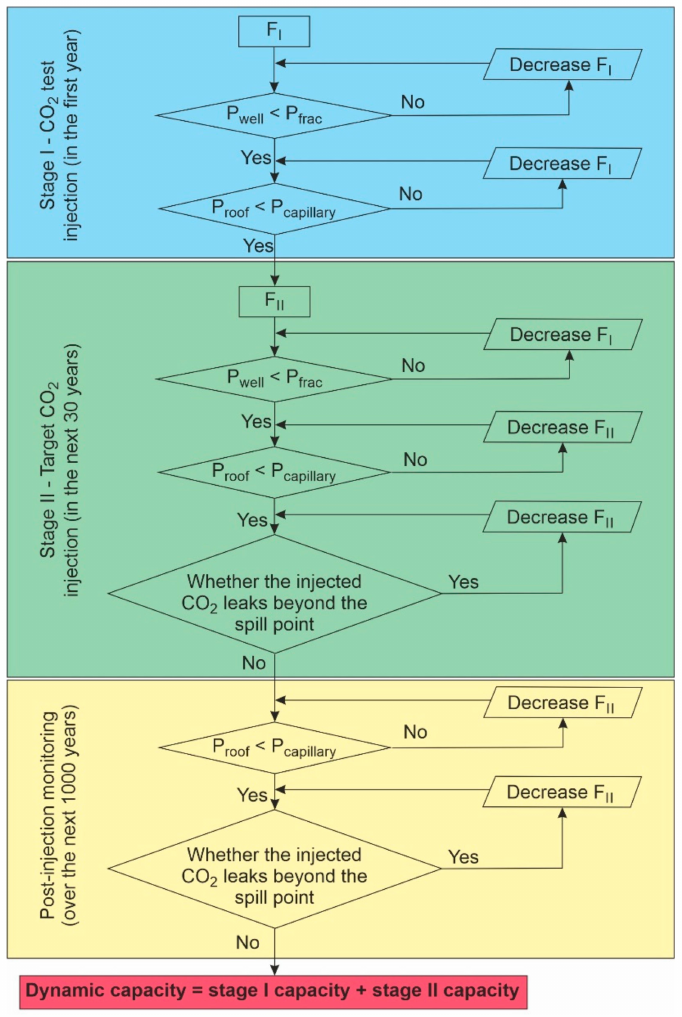
Figure 5. Procedure for determining the dynamic CO 2 storage capacity for selected structures; F I — CO 2 flow rate during Stage I—test injection; F II —CO 2 flow rate during Stage II—target injection; P well —bottom well pressure; P frac —minimum fracturing pressure; P capillary —cap rock capillary entry pressure; P roof —pressure at the top of the